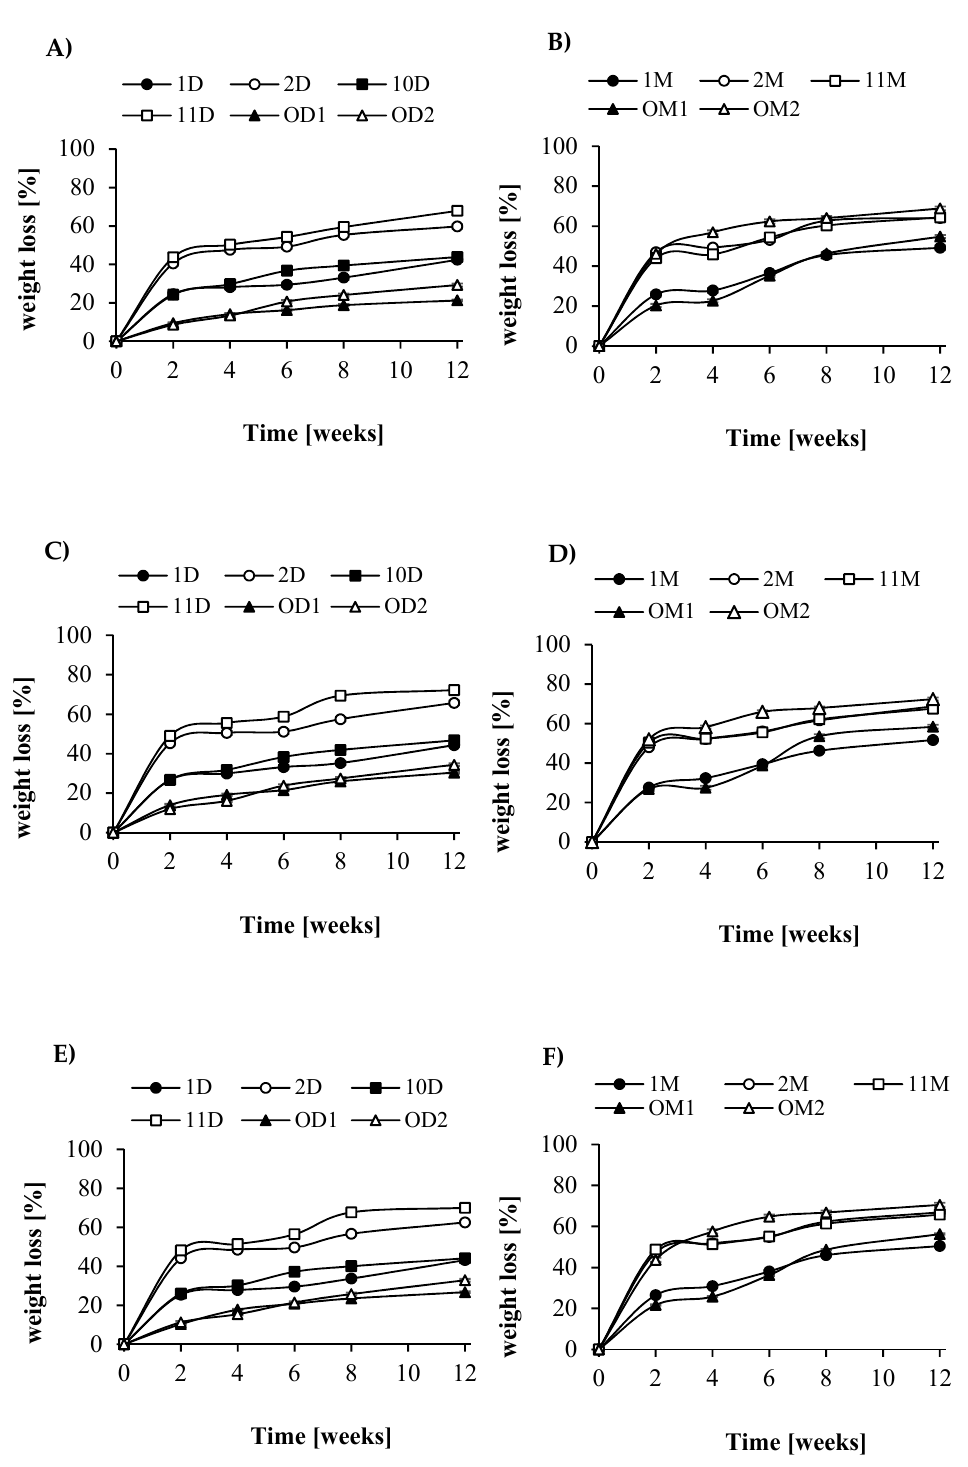
Figure5. Percentweightlossofthesamples: ( A) —LA / GA / PEG + dextrininwater, and( B) —LA / GA / PEG Figure 5. Percent weight loss of the samples: ( A) —LA/GA/PEG + dextrin in water, and ( B) — + maltodextrin in water; ( C )—LA / GA / PEG + dextrin in soil, and ( D )—LA / GA / PEG + maltodextrin LA/GA/PEG + maltodextrin in water; ( C )—LA/GA/PEG + dextrin in soil, and ( D )—LA/GA/PEG + in soil; ( E )—LA / GA / PEG + dextrin in activated sludge and ( F )—LA / GA / PEG + maltodextrin in maltodextrin in soil; ( E )—LA/GA/PEG + dextrin in activated sludge and ( F )—LA/GA/PEG + activated maltodextrin in activated sludge.